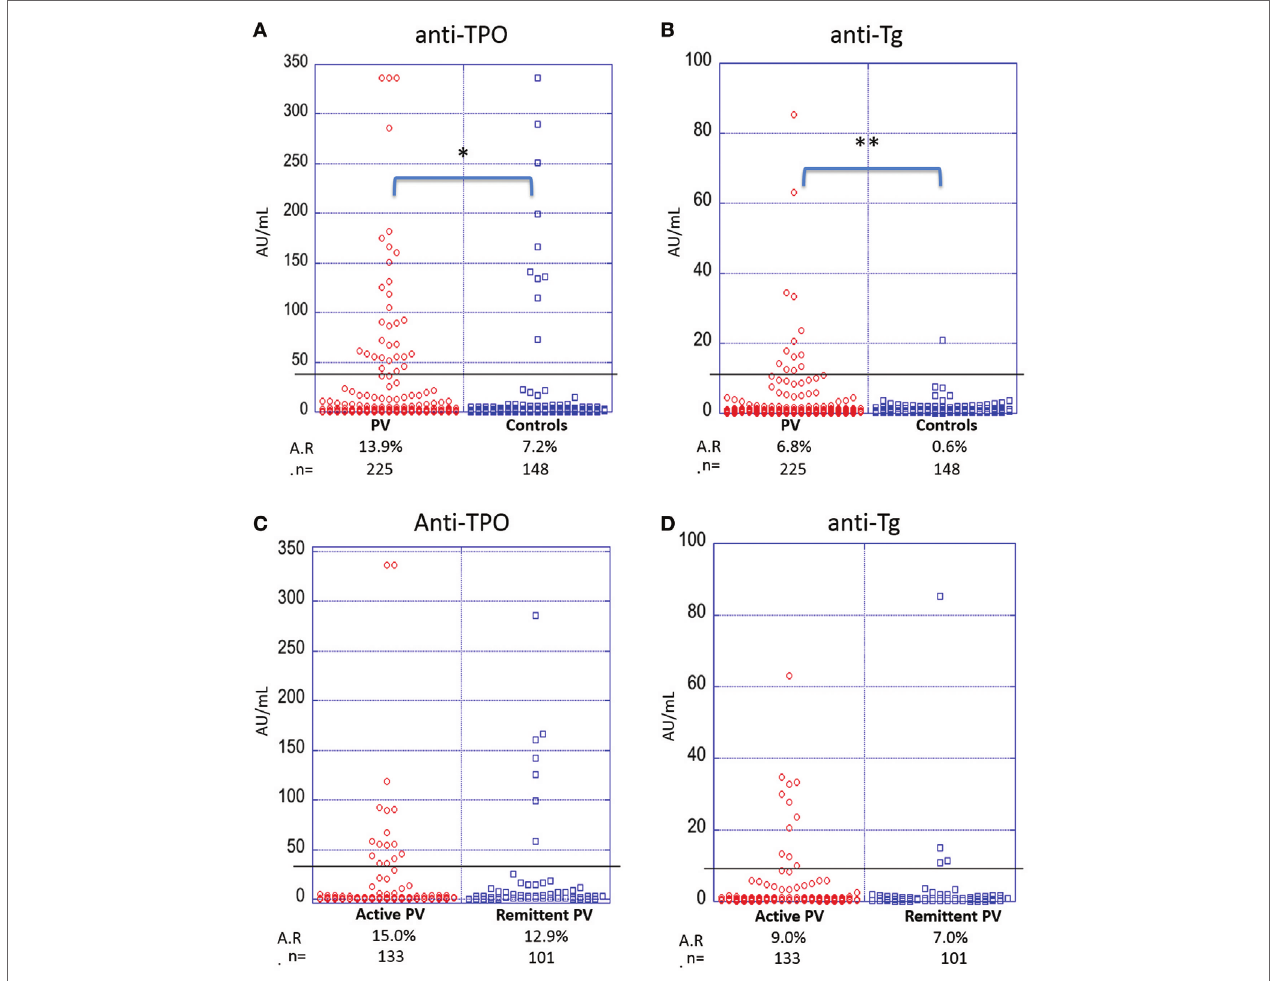
FigUre 2 | Activity rates of anti-thyroid peroxidase (anti-TPO) and anti-thyroglobulin (anti-Tg) based on disease state and disease activity. Individual dots represent anti-TPO and anti-Tg levels (in AU/ml) in pemphigus vulgaris (PV) patients vs. controls (a,b) and active vs. remittent PV patients (c,D) for anti-TPO (a,c) and anti-Tg (b,D) antibodies (* p < 0.05 and ** p < 0.01). Abbreviation: A.R., activity rate. Anti-TPO and anti-Tg antibody rates were modeled as a function of disease status and activity using a generalized estimating equations logistic regression